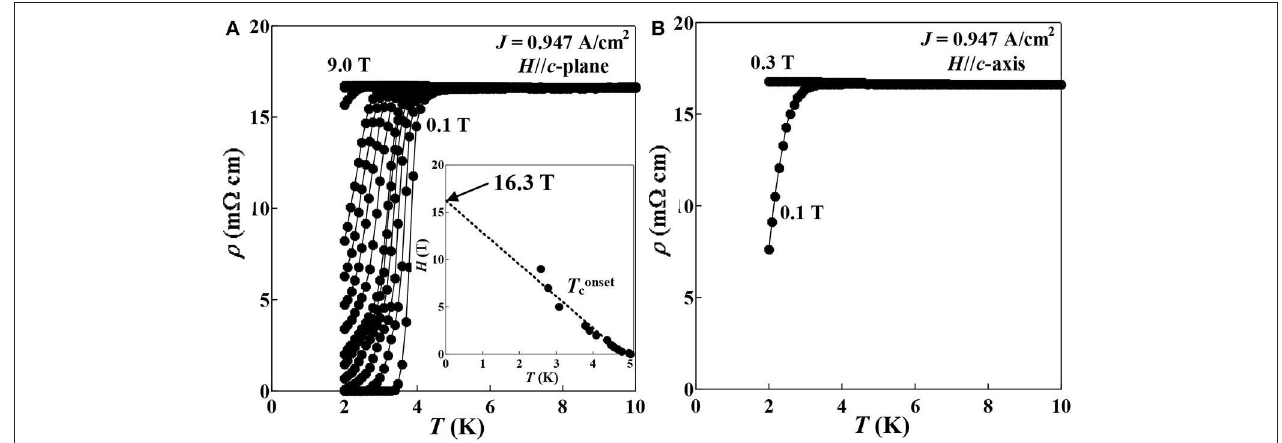
FIGURE 9 | Temperature ( T ) dependence of resistivity ( ρ ) for (Ce,Pr)OBiS 2 with x = 0.9 single crystal under the magnetic fields ( H ) parallel to the (A) c -plane ( H = 0.1–9.0T) and (B) c -axis ( H = 0.1-0.3T). The inset of (A) is the magnetic fields dependence of the T onset c for (Ce,Pr)OBiS 2 with x = 0.9 single crystal under the magnetic field ( H ) parallel to the c -plane ( H // c -plane), and the lines are liner fits to the data.